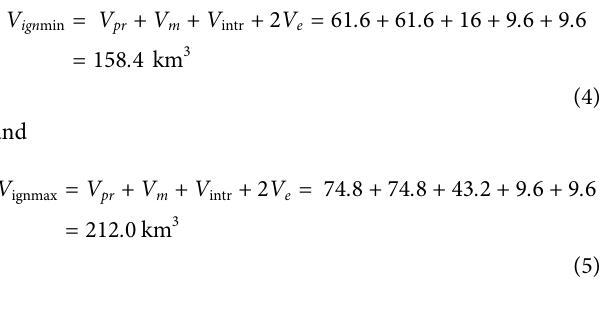
Frontiers in Earth Science |